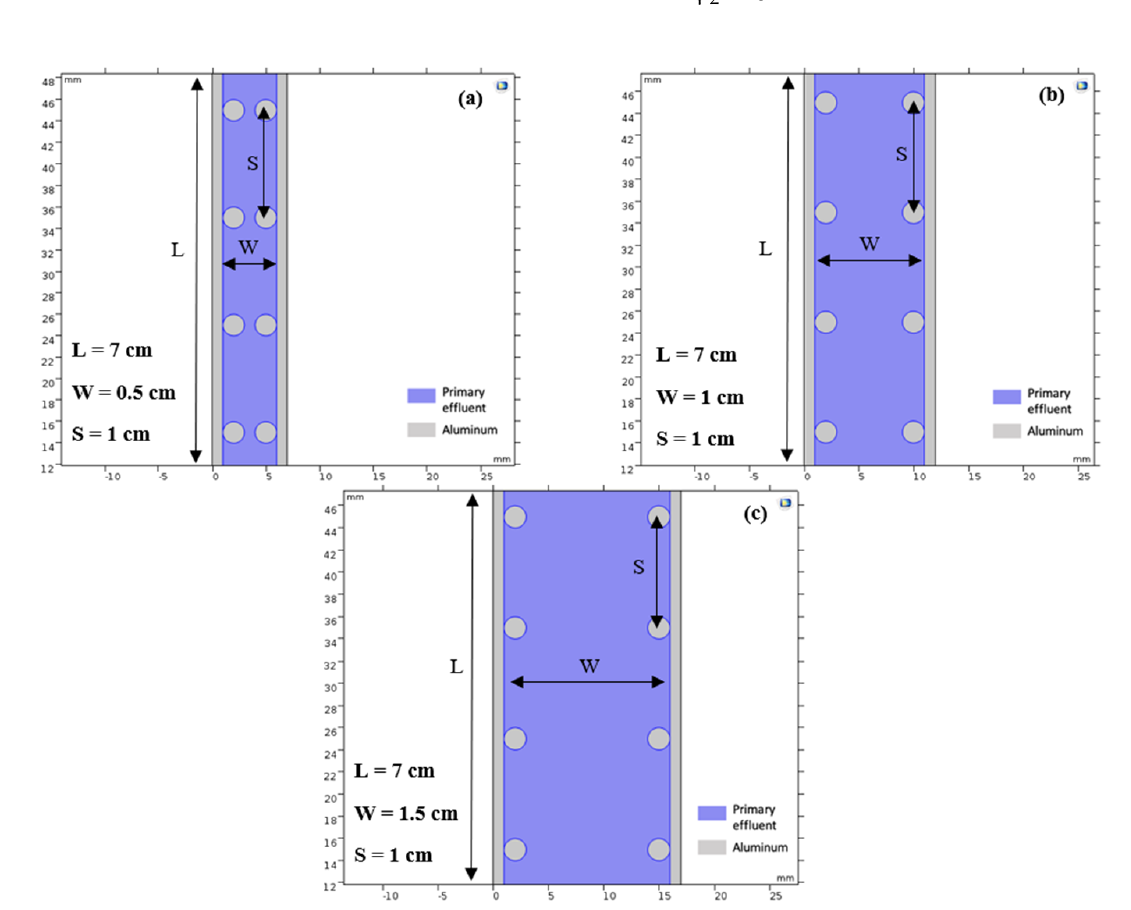
Figure 3. Illustration of the geometrical parameters of the simulated electrodes using three electrode spacings: ( a ) 0.5 cm, ( b ) 1 cm and ( c ) 1.5